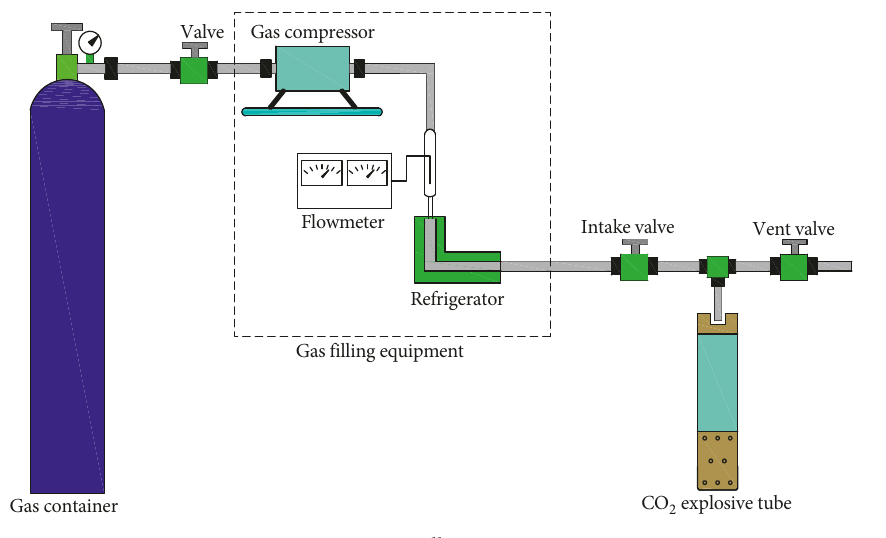
Figure 1: Filling